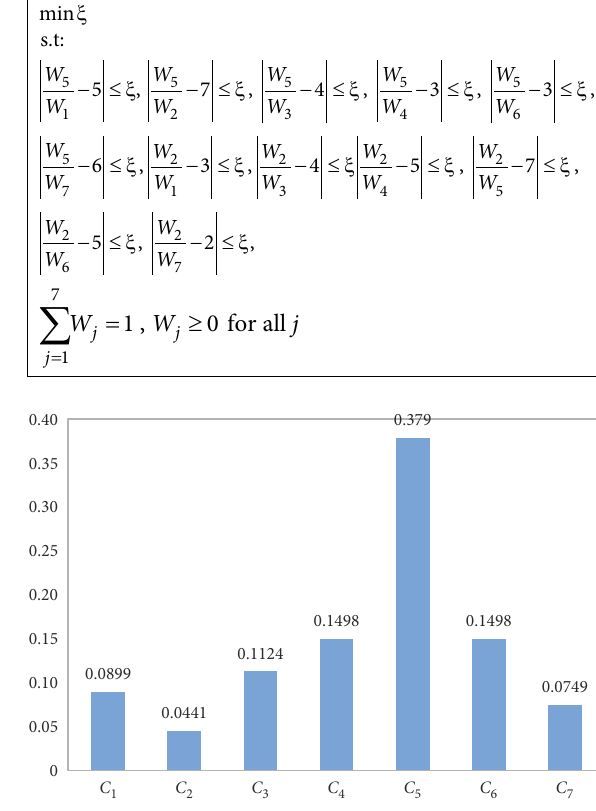
Figure 2. The BWM method